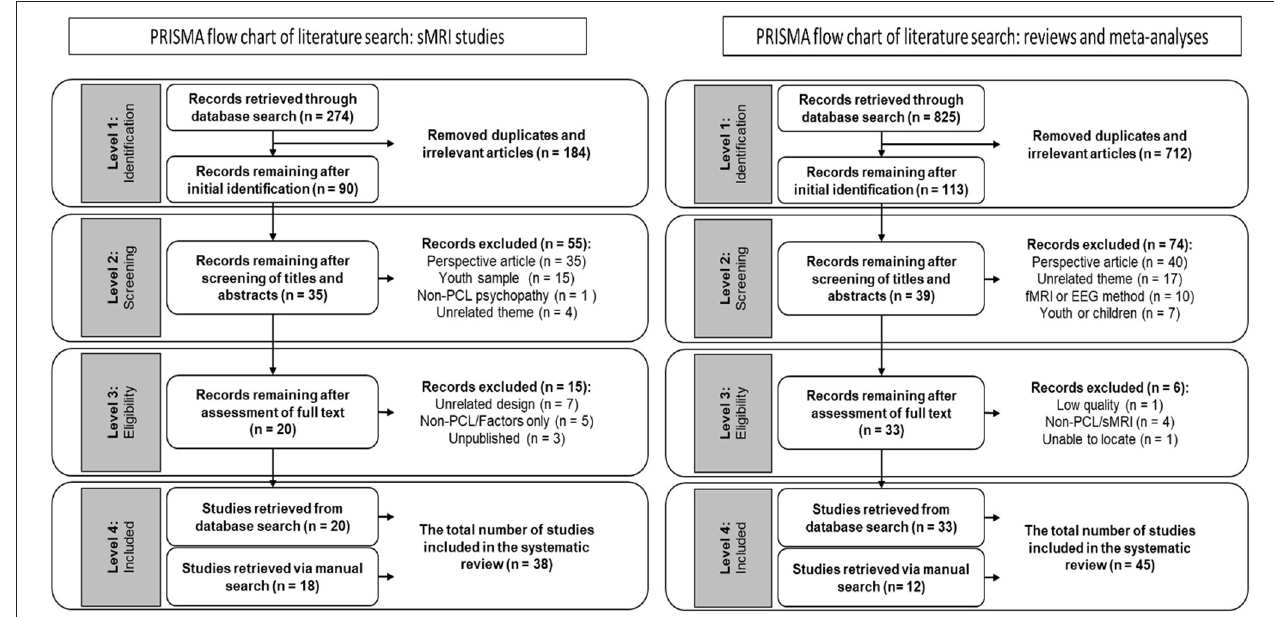
FIGURE 1 | PRISMA flow